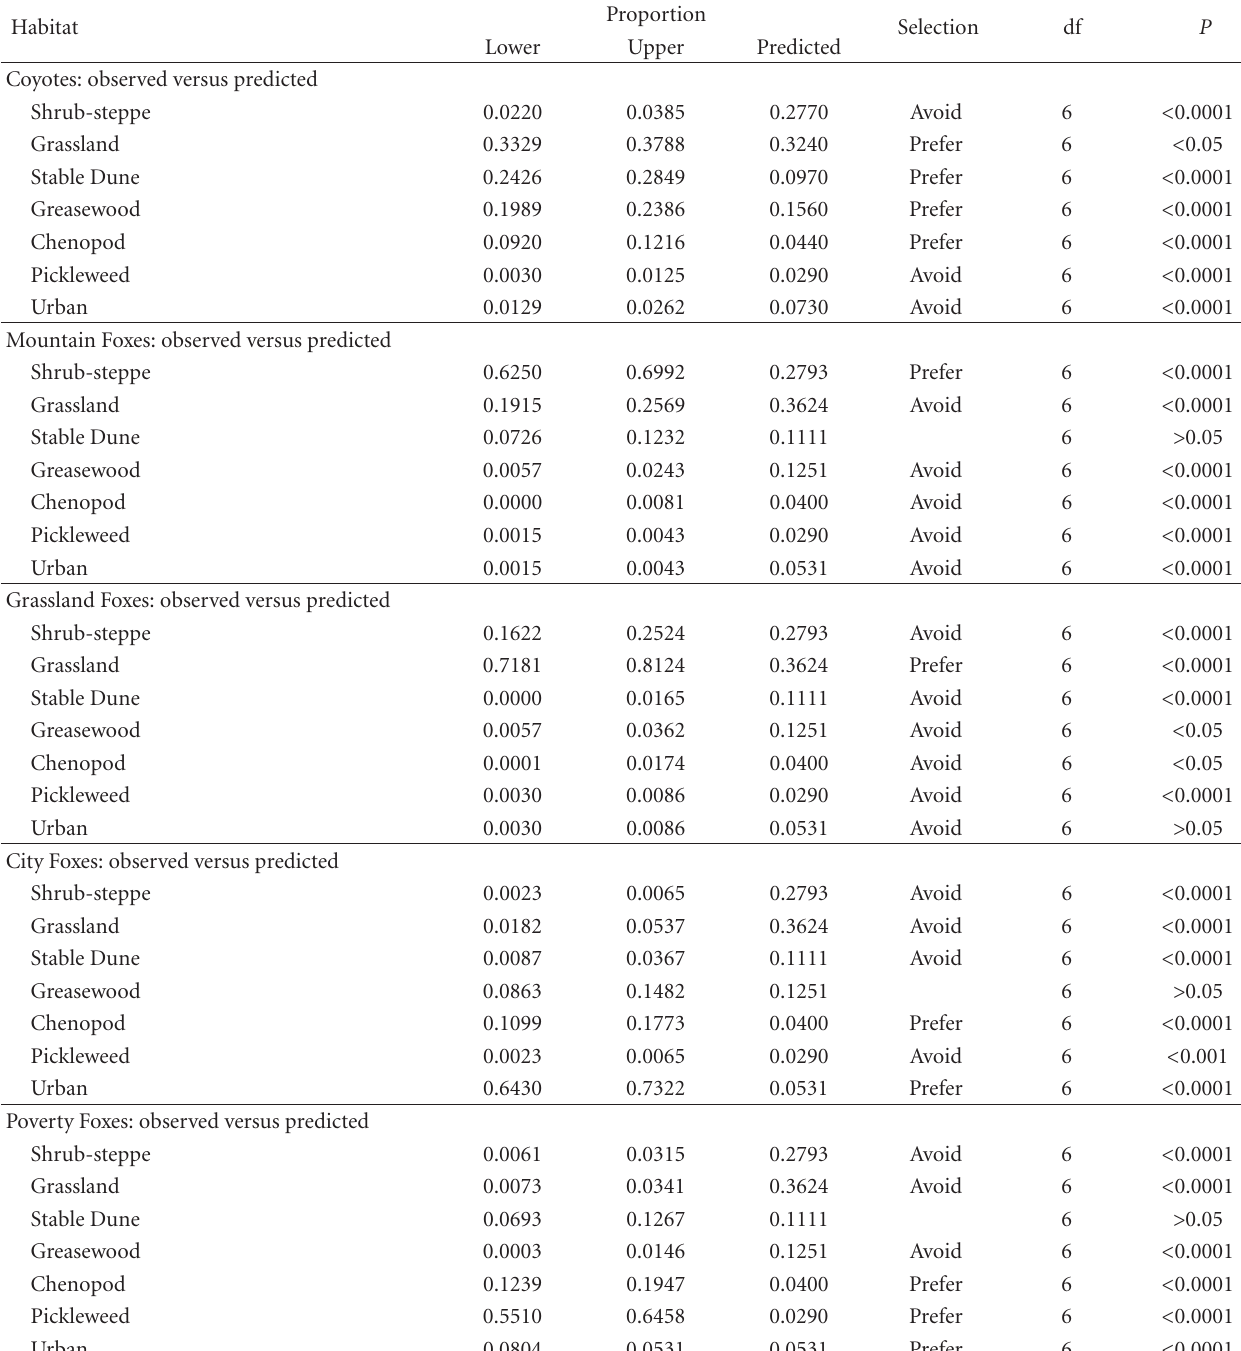
Table 3: Comparisons between observed (lower and upper) and predicted canid distributions analyzed using the chi-square goodness-of- fit test [14]. Significant di ff erences between distributions were detected using Bailey simultaneous confidence intervals. Habitats that were avoided were used less frequently than predicted; preferred habitats were used more than